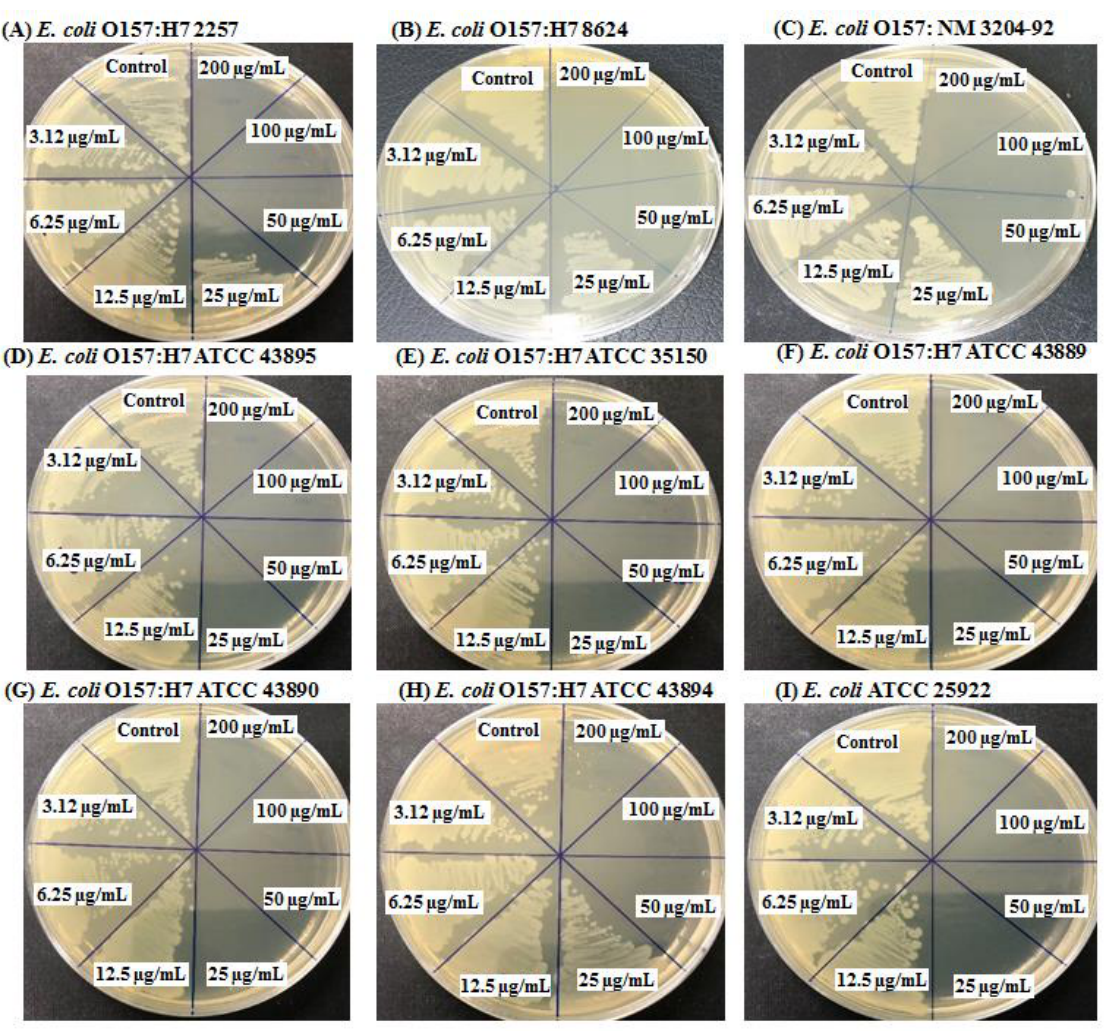
Figure 9. MBC of probiotic-mediated synthesized AgNPs against E. coli O157:H7 strains ( A – I ).